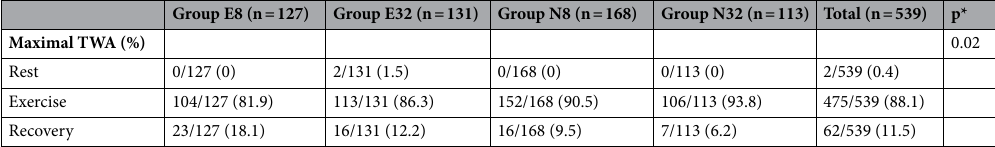
Table 2. Distribution in percentage of the moment of occurrence of maximal TWA during the exercise test. Groups: E8 = Ellestad factor 1/8; E32 = Ellestad factor 1/32; N8 = Naughton factor 1/8; N32 = Naughton factor 1/32. *Fisher’s exact